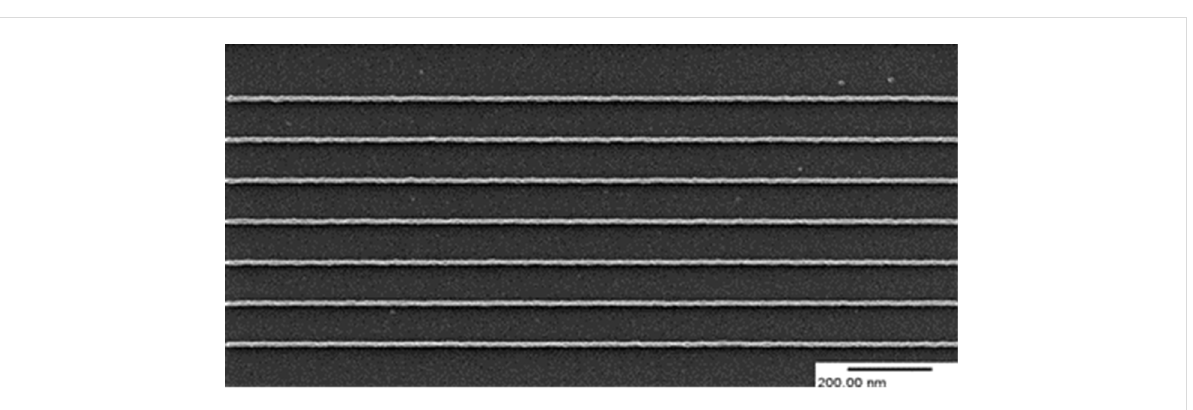
Figure 5: Isolated dose-optimised SHIBL experiments on HM01 fullerene resist: 8 nm wide sparse exposed using 30 keV He + ions [41].